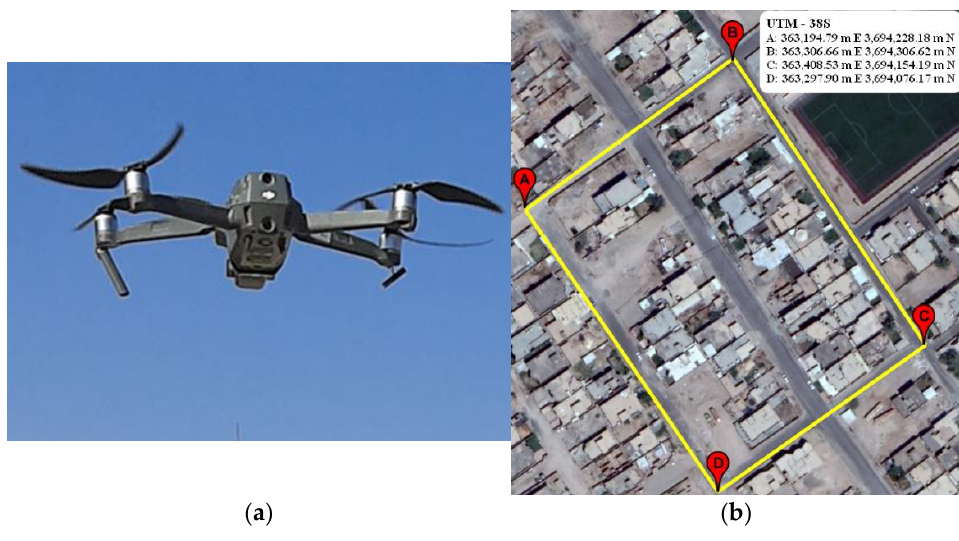
Figure 2. ( a ) DJI Mavic Pro 2 at the study area; ( b ) the study area.